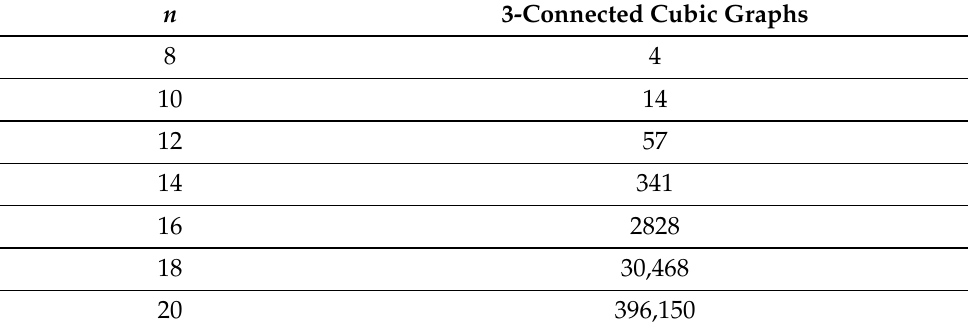
Table 2. 3-connected cubic